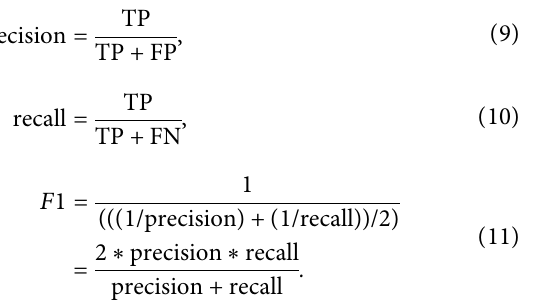
Figure 6(a) is Scheme 1: first, TF-IDF algorithm, and then TextRank algorithm. After word segmentation and stop